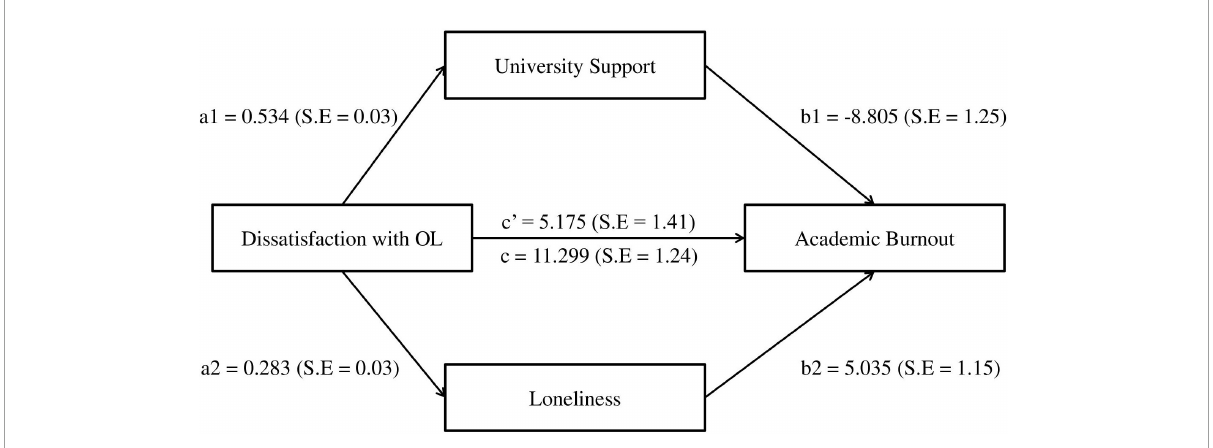
FIGURE3 Mediating effect of university support and loneliness in the relation between dissatisfaction with OL and academic burnout ( N = 975) during the COVID-19 pandemic. Note: all significance level at p < 0.001; all presented effects are unstandardized; a1 – the effect of dissatisfaction with OL on university support; b1 – the effect of academic life satisfaction on academic burnout; a2 – the effect of dissatisfaction with OL on loneliness; b2 – the effect of loneliness on academic burnout; c’ is the direct effect of dissatisfaction with OL on academic burnout, and c is the total effect of dissatisfaction with OL on academic burnout.